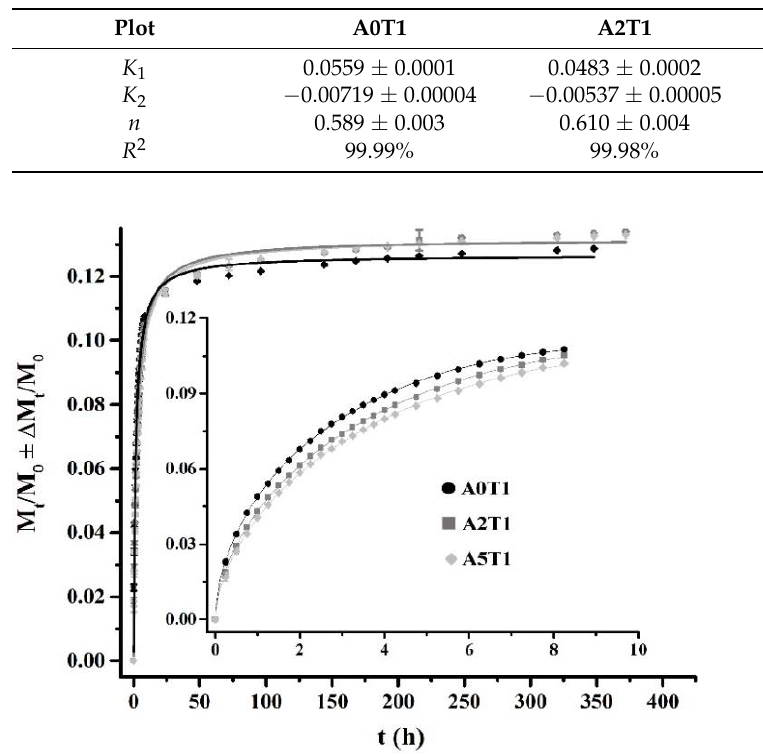
Figure 4. Tetracycline release profiles fitting to Equation (6) (the inset, first 8 h) and Equation (7), from the beginning to the end of the process.